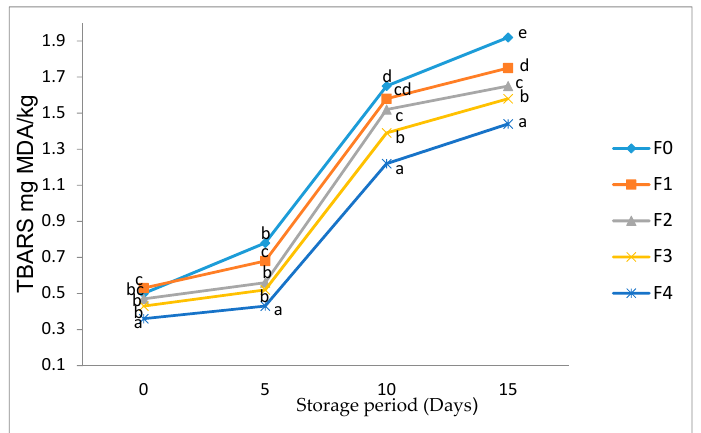
Figure 1. Effects of MOLP on thiobarbituric acid reactive substances (TBARS) of ground beef stored at 4 ± 1 °C for 15 days. Means with different superscripts show significant difference among treatments within same storage day at p ≤ 0.05. F0 (100% ground beef), F1 (0.2%), F2 (0.4%), F3 (0.6%), and F4 (0.8%) Moringa oleifera leaves powder.